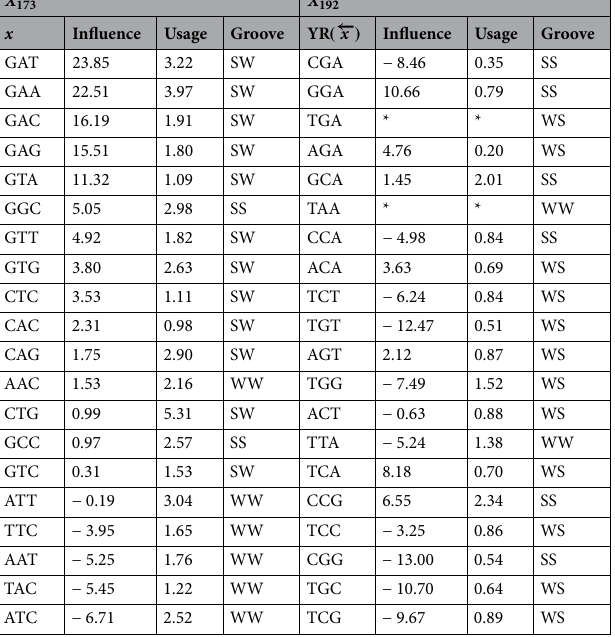
Table 2. Codons of circular codes X 173 and X 192 together with their codon influence as in 5 their codon usage in E.coli and the mRNA groove described as the Strong/Weak nature of the first two nucleotides of the codon. The columns are ordered in descending order according to the codon influence index for code X 173 (second column).